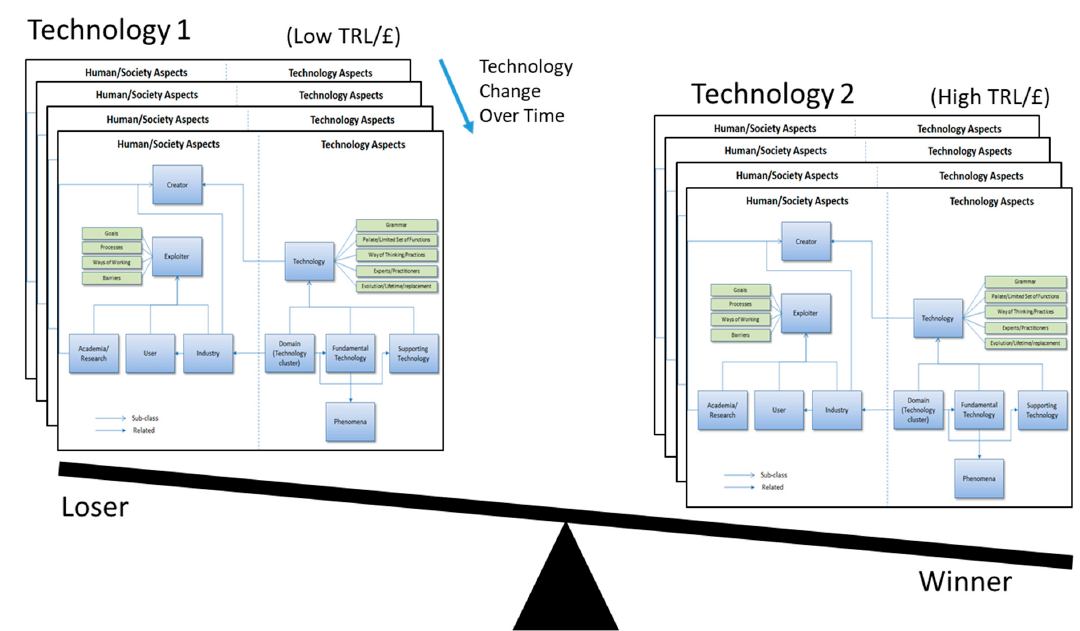
Figure 7. Model change over time (Arthur (2009) [7] and Christensen (1997) [4]).